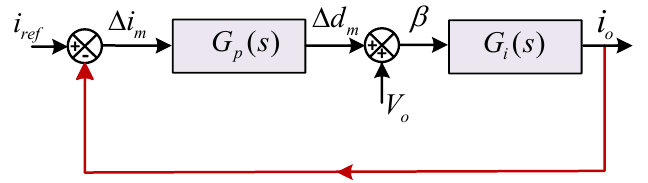
Figure 4. Diagram of closed loop current control for proposed converter.